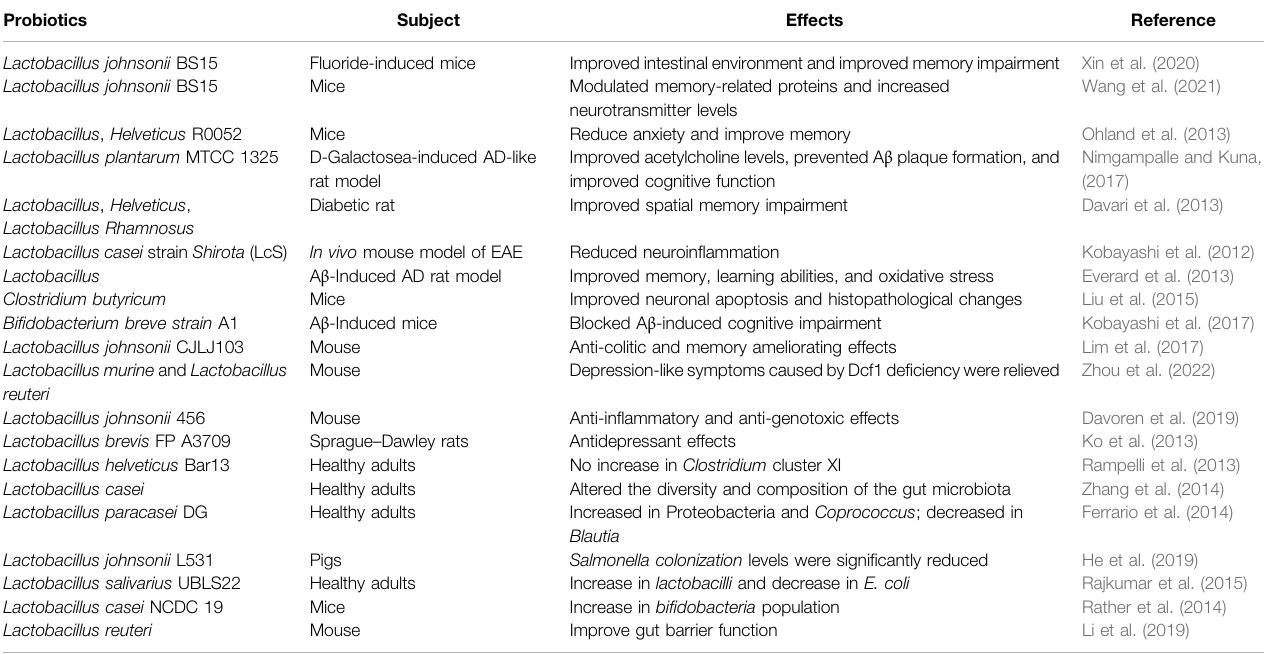
TABLE 2 | Effects of probiotics on neurological disorders and gut